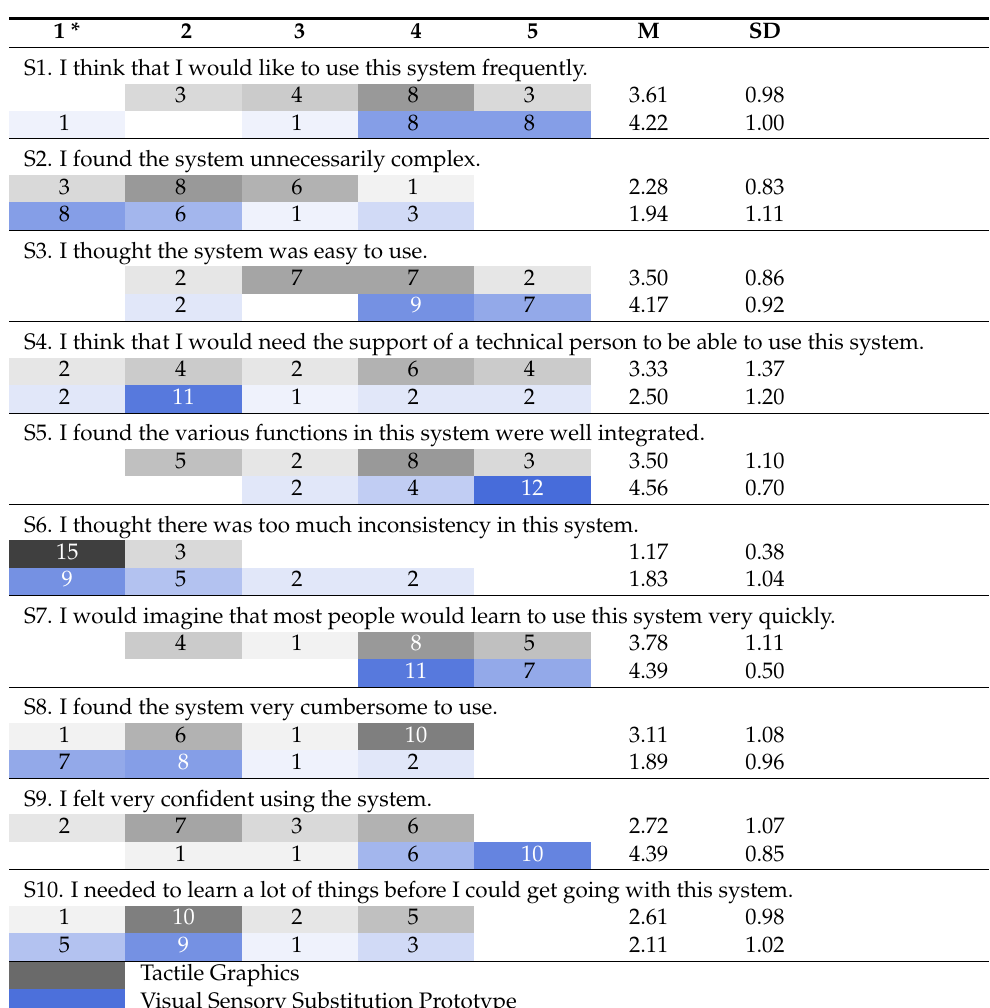
Table 11. Tactile Graphics and Visual Sensory Substitution Prototype System Usability Survey